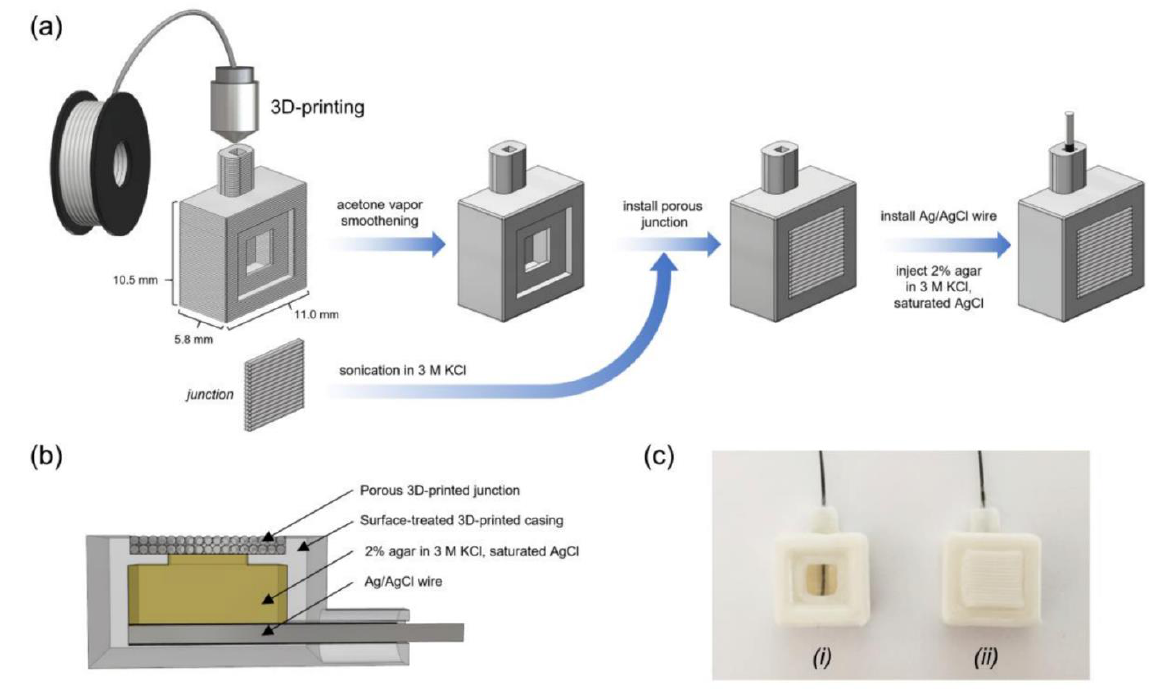
Figure 5. Design and fabrication of 3D-printed reference electrode (3D-RE). ( a ) Scheme illustrating the fabrication process of the 3D-RE. ( b ) Cross section of the 3D-RE. ( c ) Photograph of assembled 3D-RE ( i ) without a junction installed and ( ii ) with a junction installed. Reproduced with permission from Sibug-Torres et al. [32], Chemosensors, 8, 30. Published by MDPI, 2020.